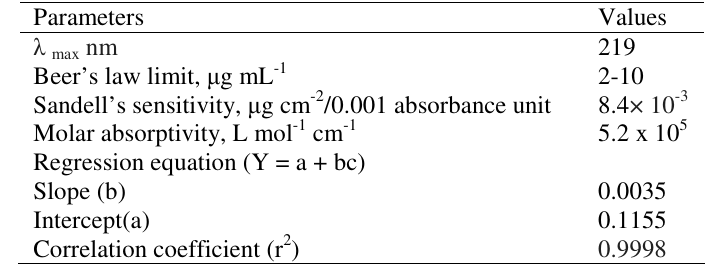
Table 2. Assay results and precision